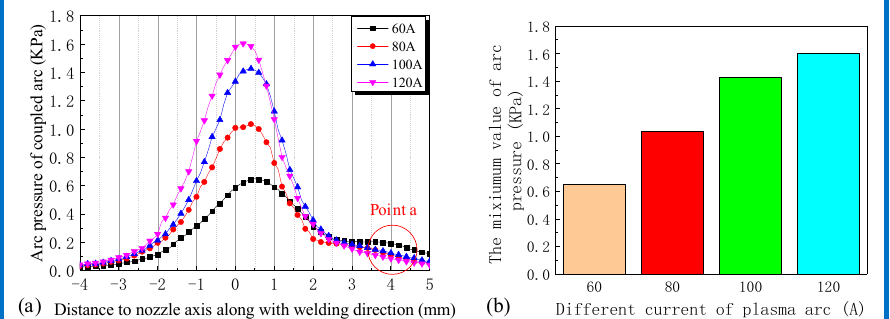
Figure 9. Coupled arc pressure with different plasma current. ( a ) Coupled arc pressure along with welding direction. ( b ) Max value of coupled arc pressure.